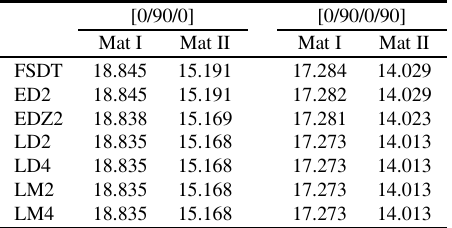
Table 3 Deterministic dimensionless fundamental frequency ω